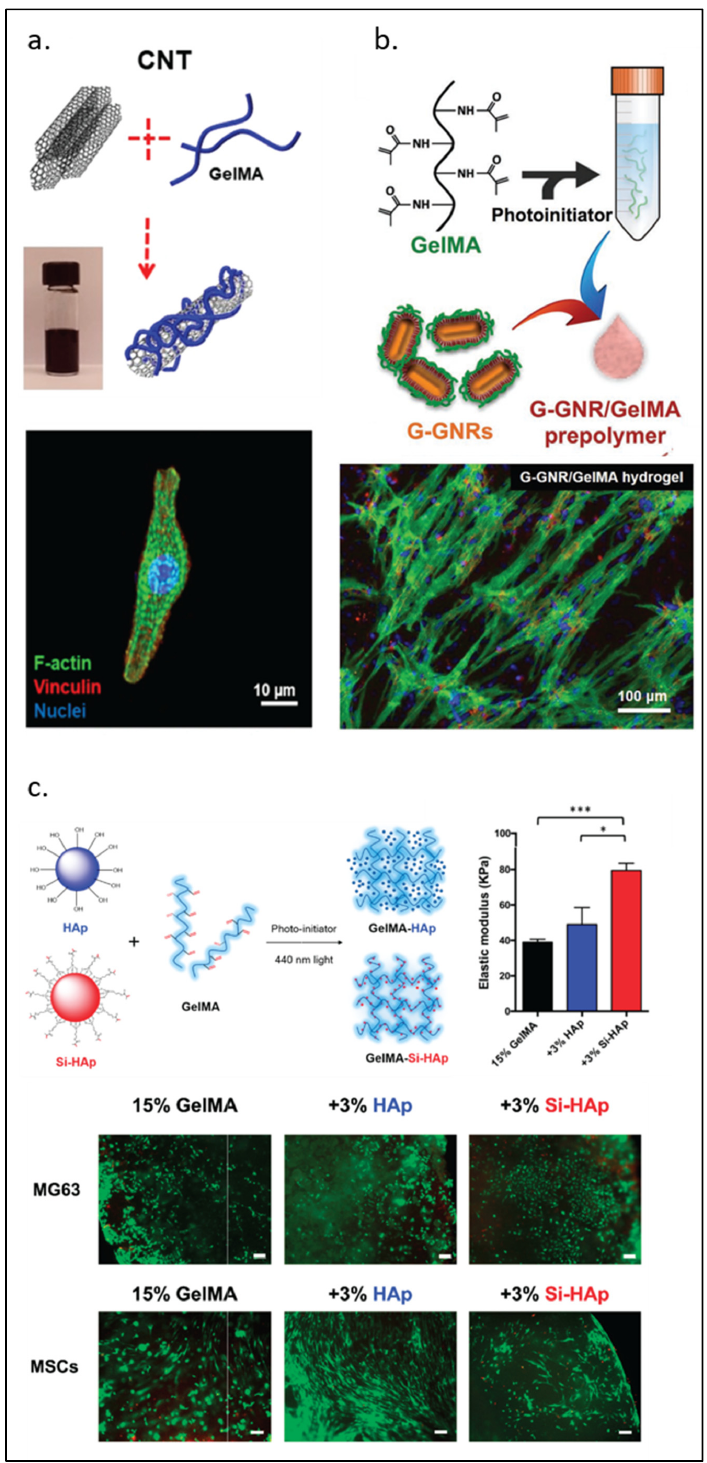
Figure 6. GelMA modified by nanomaterials. ( a ) Carbon nanotubes. ( b ) Gold nanorods for cardiomyocyte constructs. ( c ) Biofabrication of silanized hydroxyapatite modified cell-laden GelMA and MG63 cells and human mesenchymal stem cells (MSCs) encapsulation by GelMA composite (green, calcein AM; red, ethidium homodimer-1). Scale bar, 100 µ m. Elastic modulus of GelMA-HAp and GelMA-Si-HAp hydrogels data is presented as mean ± standard deviation. * p < 0.05, *** p < 0.001 upon one-way ANOVA analysis (upper right). Reproduced (adapted) with permission from Ref. [50]. 2019 © ACS Nano. Ref [57]. 2017 © Advanced Functional Materials Smart Materials in Medicine. And Ref. [63]. 2021 ©